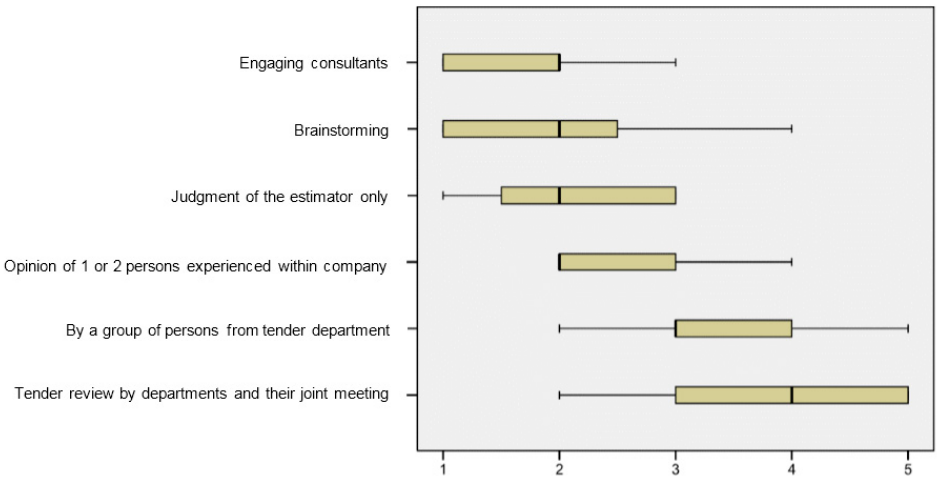
Figure 5. Company procedure for risk identification.